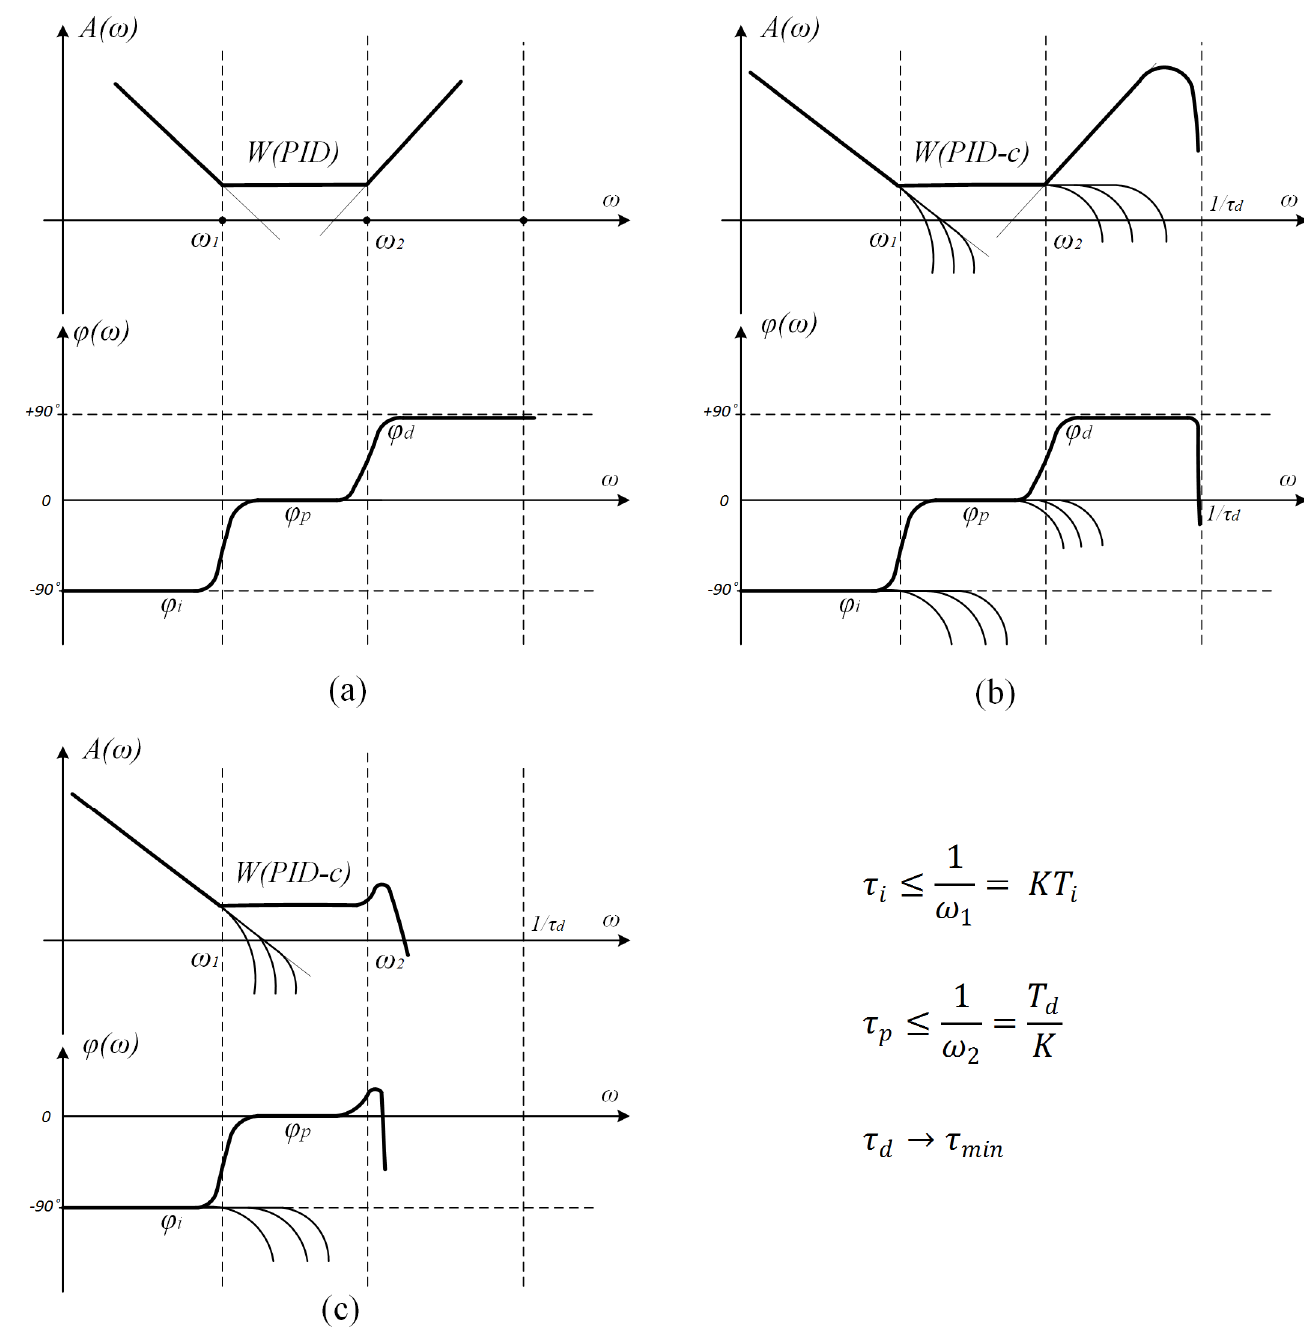
Figure 5. Logarithmic amplitude − frequency characteristics of the PID controller at various delays of the “zero-order hold” link.